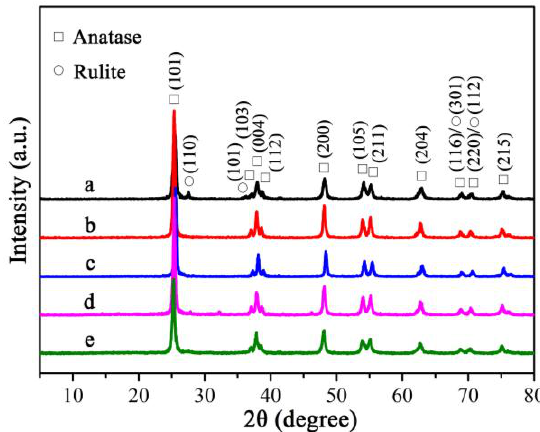
Figure 1. X-ray diffraction (XRD) patterns of TiO 2 hollow spheres (THS) loaded by the cocatalysts with different spatial dispersion: ( a ) THS; ( b ) Ag-loaded THS on the inner surface (Ag-I-THS); ( c ) RuO 2 -loaded THS on the outer surface (RuO 2 -O-THS); ( d ) Ag- and RuO 2 -co-loaded THS on the inner surface and outer surface (Ag-I-RuO 2 -O-THS); ( e ) RuO 2 - and Ag-co-loaded THS on the inner surface and outer surface (RuO 2 -I-Ag-O-THS).